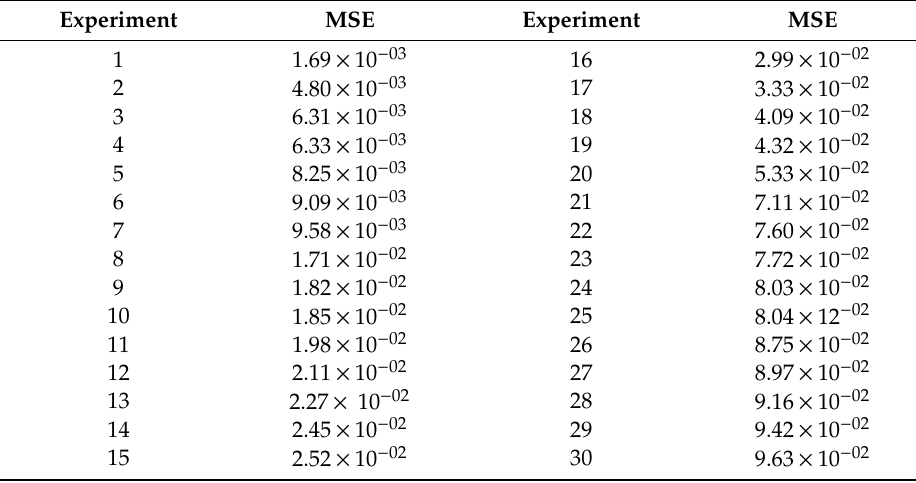
Table 17. Results obtained with DSO.